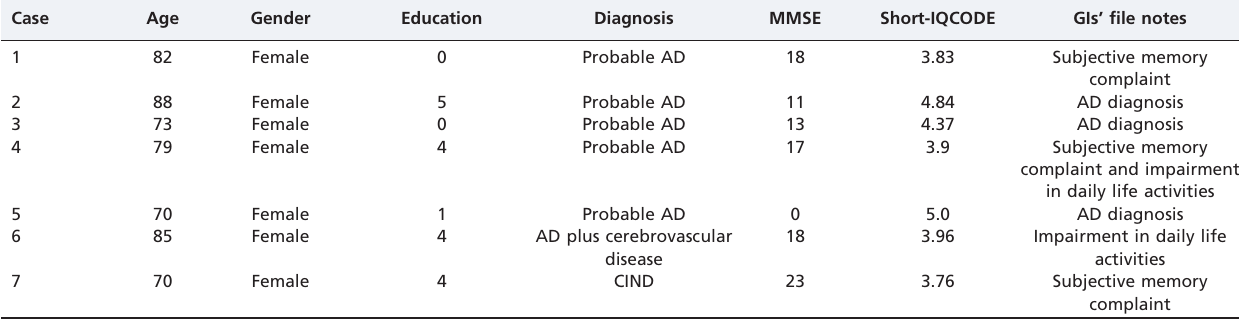
Table 3 - Patient demographic data, diagnoses, MMSE and Short-IQCODE scores, and records from general internists’